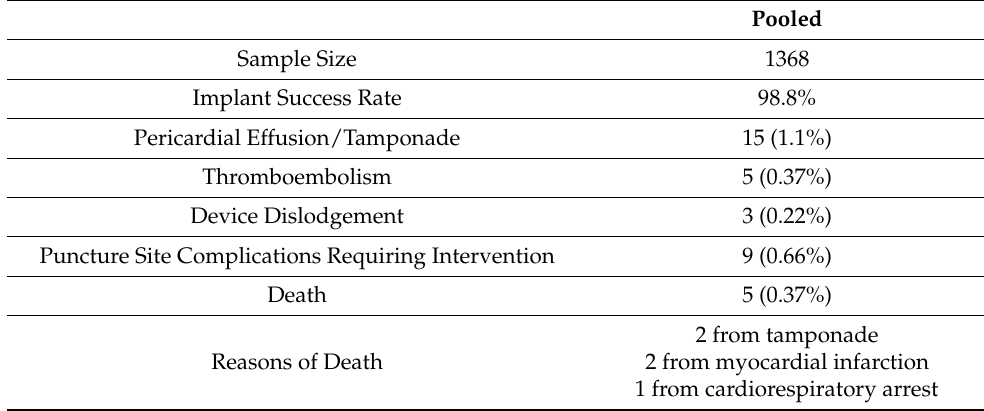
Table 3. LAAO implant success and LAAO procedure- or device-related serious